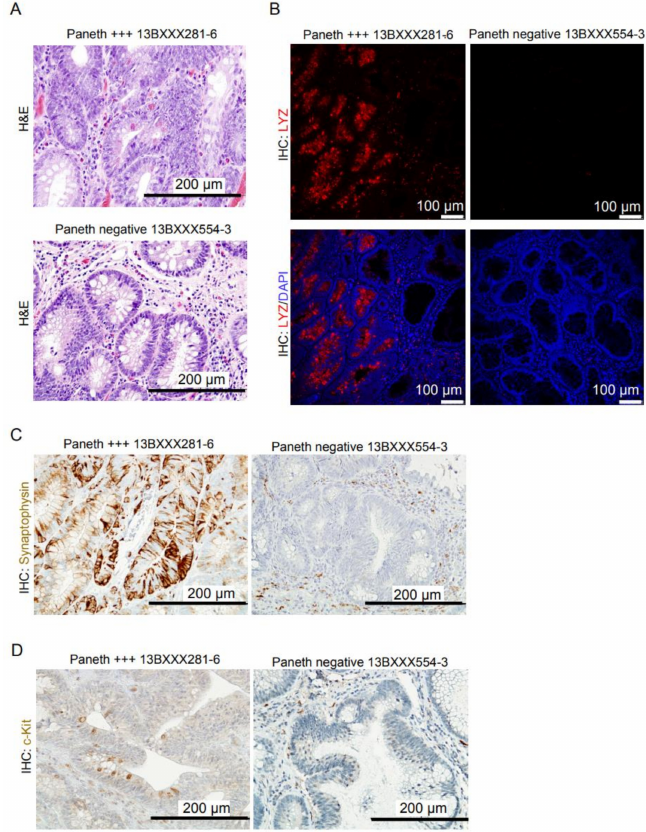
Figure 1. Adenomas accumulates Paneth cells that are c-Kit and synaptophysin-positive. ( A ) Rep- resentative hematoxylin and eosin staining of adenoma samples considered as Paneth cell-positive and -negative. ( B ) Immunofluorescence (IF) analysis of Paneth cell-positive and -negative sam- ples with the Paneth cell marker lysozyme (LYZ). DAPI staining was used for nuclei detection. ( C , D ) Immunohistochemical (IHC) analysis of synaptophysin ( C ) and c-Kit markers ( D ) in the indi- cated samples. +++ indicates the degree of positivity in this particular samples as determined by the